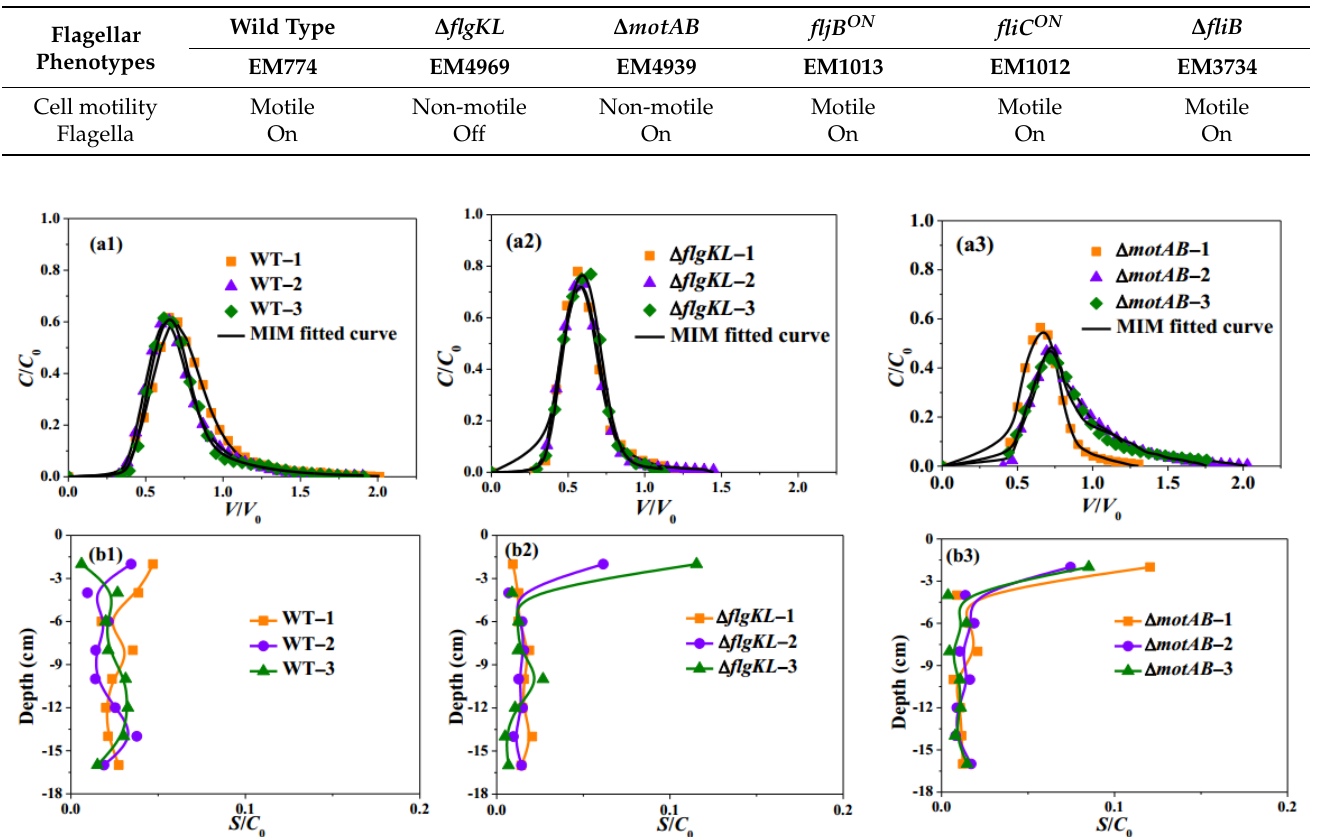
Table 1. Cell properties for S. Typhimurium strains.